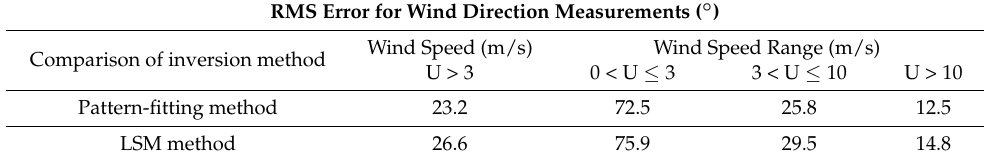
Table 4. Comparison of the root-mean-square (RMS) error of the wind direction related to wind speed using the pattern-fitting and least-square minimum (LSM) methods in the Fedje